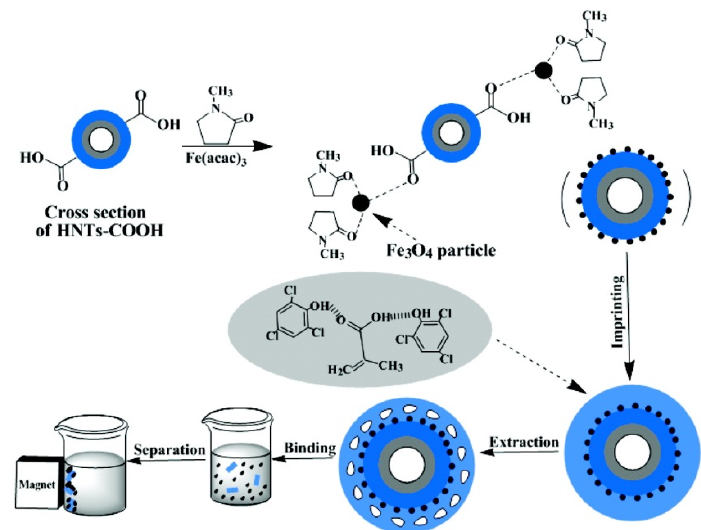
Figure 13. Synthesis of molecular imprinted polymers (MMIPs) and their application for removal of 2,4,6-TCP (trichlorophenol) with the help of an applied magnetic field. Reproduced with permission from [129].